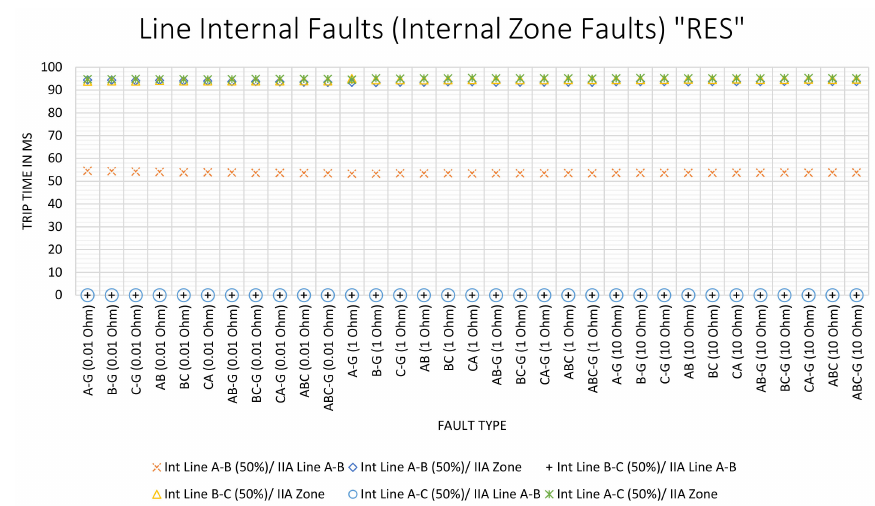
Figure 13. Results for line internal faults tests, Side B with RES.